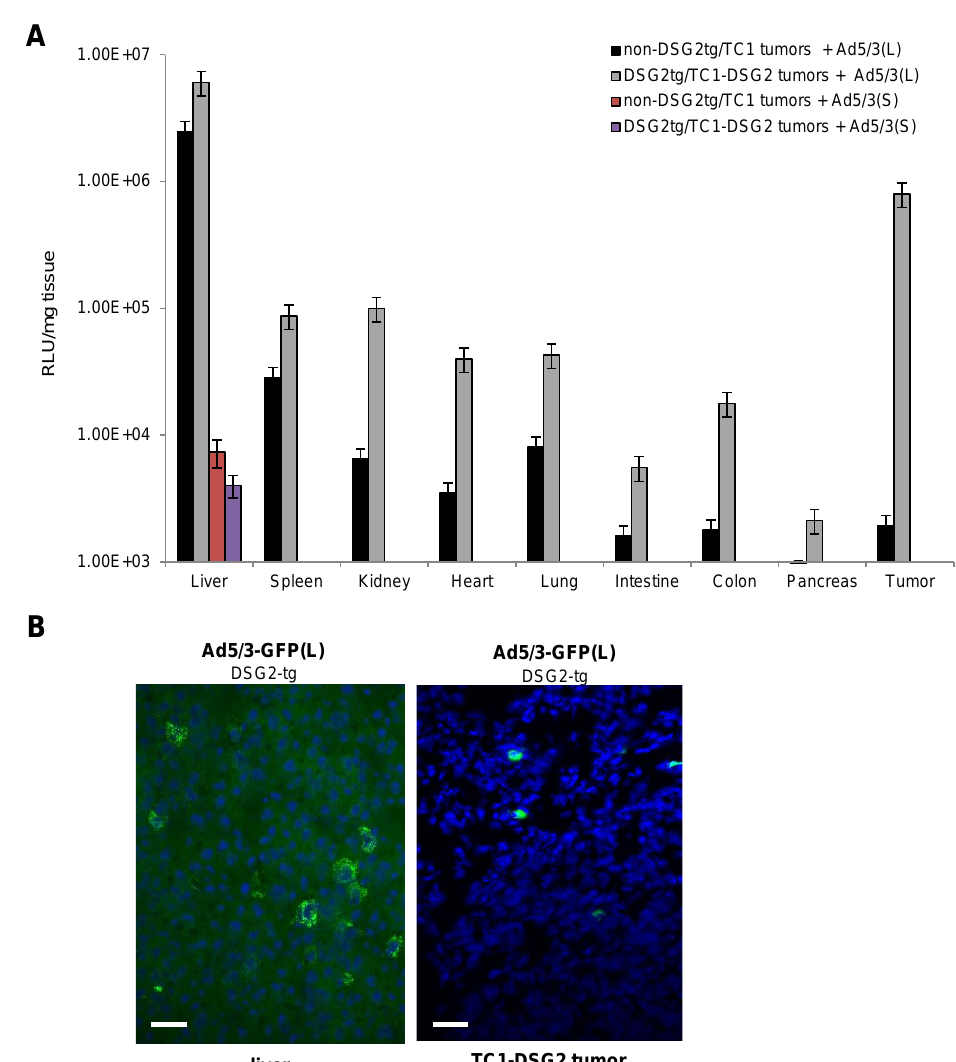
Figure 7. Luciferase activity measured in organs and the tumor harvested on day 3 after intravenous Ad5/3-luc virus injection. ( A ) Summary of luciferase activity data. Shown are data for tumor-bearing DSG2-transgenic and non-transgenic mice injected with the two Ad5/3-luc vectors. Signals from Ad5/3(S)-injected mice were below background, except for the liver. n = 3, * p <0.05. ( B ) Immunofluorescence staining with a luciferase-specific antibody (FITC — green) of liver and tumor sections from a DSG2-tg mouse injected with Ad5/3(L).